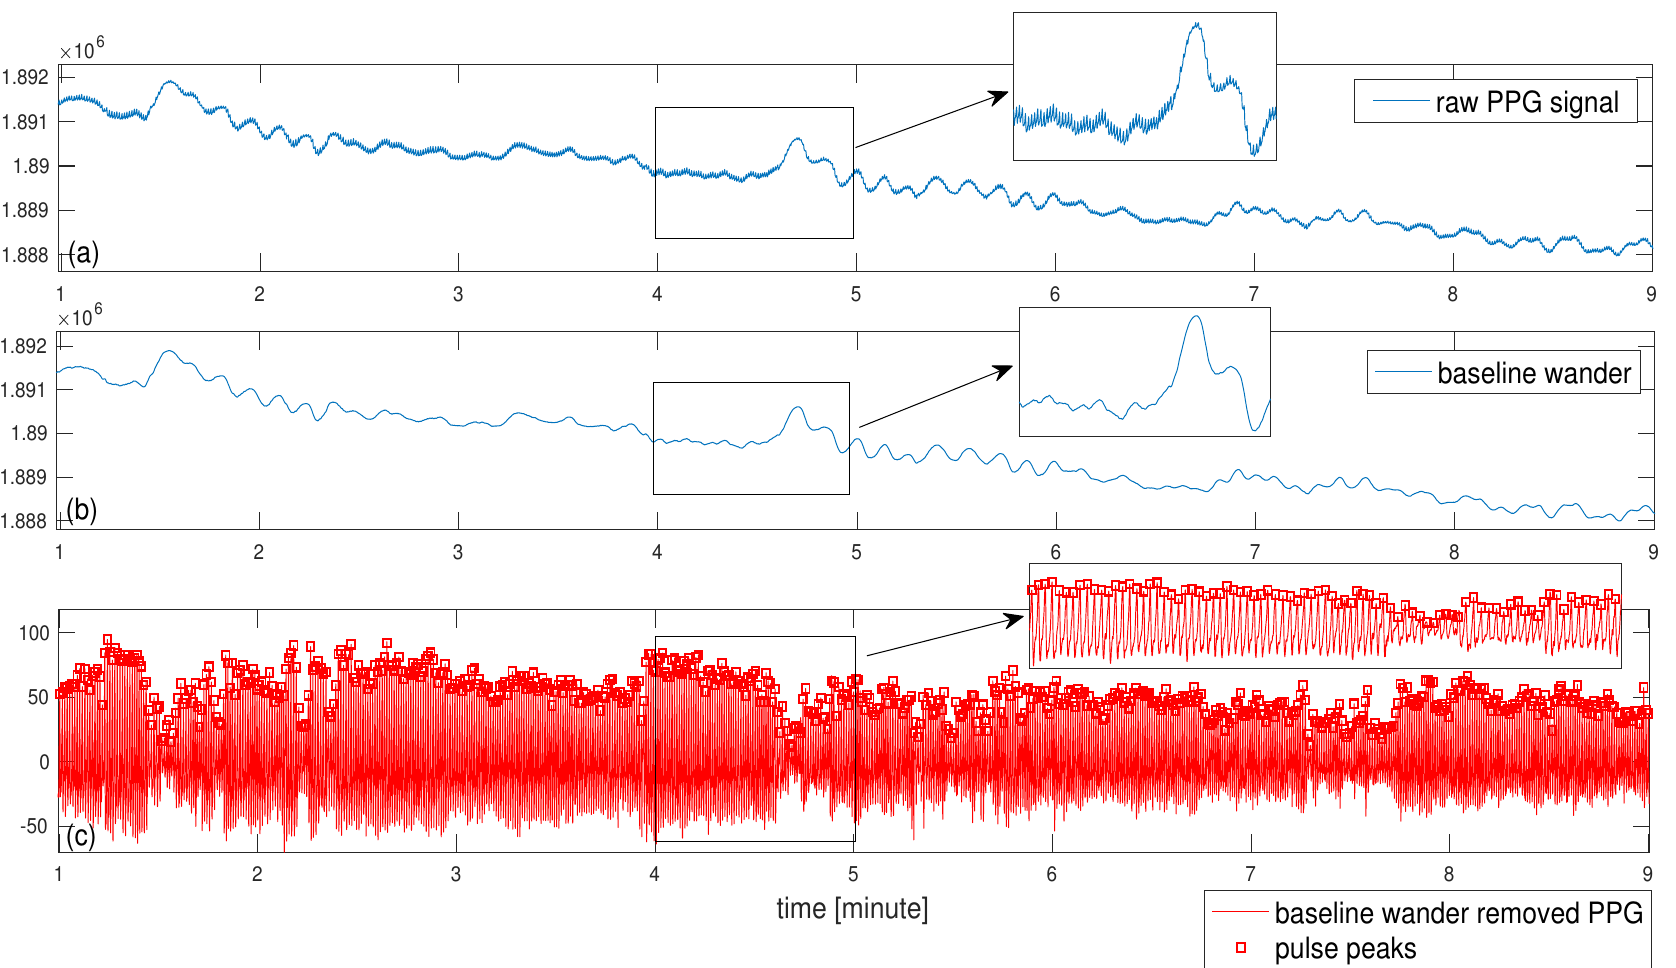
Figure 7. ( a ) Raw PPG signal (infrared); ( b ) Baseline wander that is removed from raw PPG signal in ( a ); ( c ) Separated pulse signals by subtraction of baseline wander from ( a ) using SSA algorithm (see Algorithm 1). Detected pulse are located into the baseline wander removed